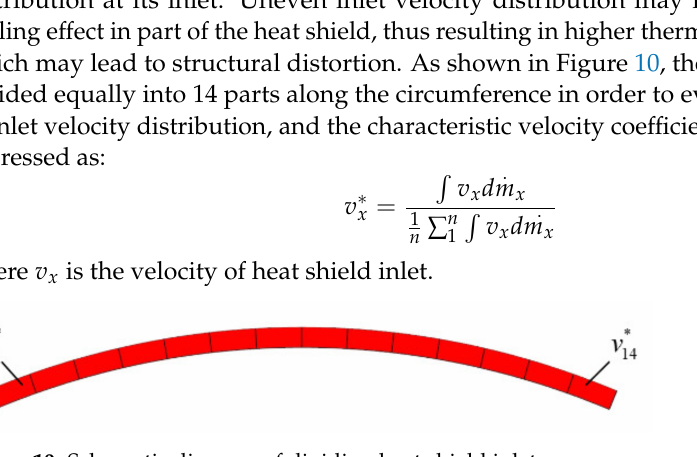
Figure 10. Schematic diagram of dividing heat shield